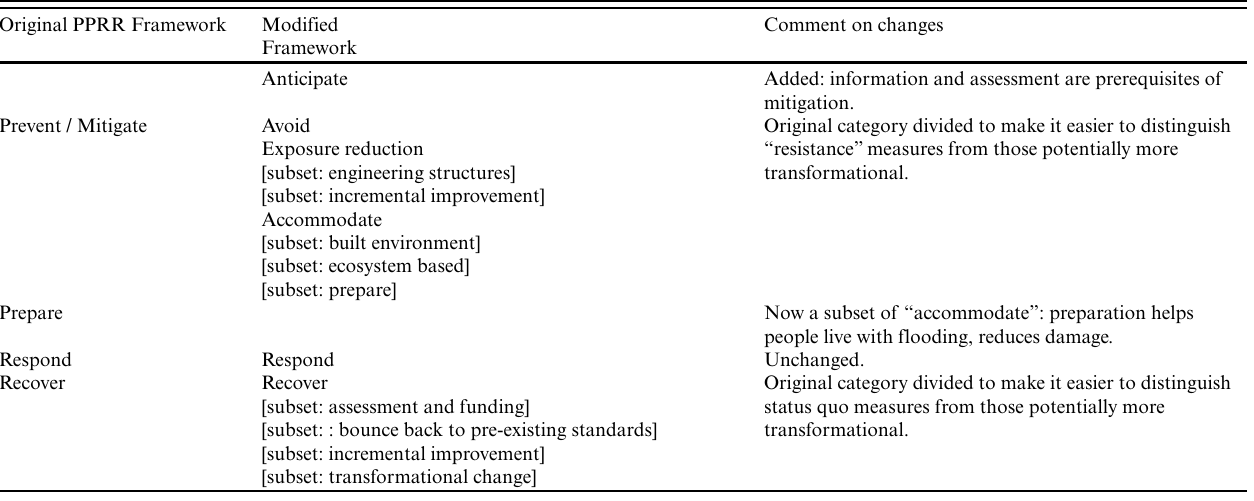
Table 1 . The modified prevent-prepare-respond-recover (PPRR) framework used in this study. The table shows both the original PPRR framework and the revised framework categories. Activities were grouped under categories and can be found in Appendix